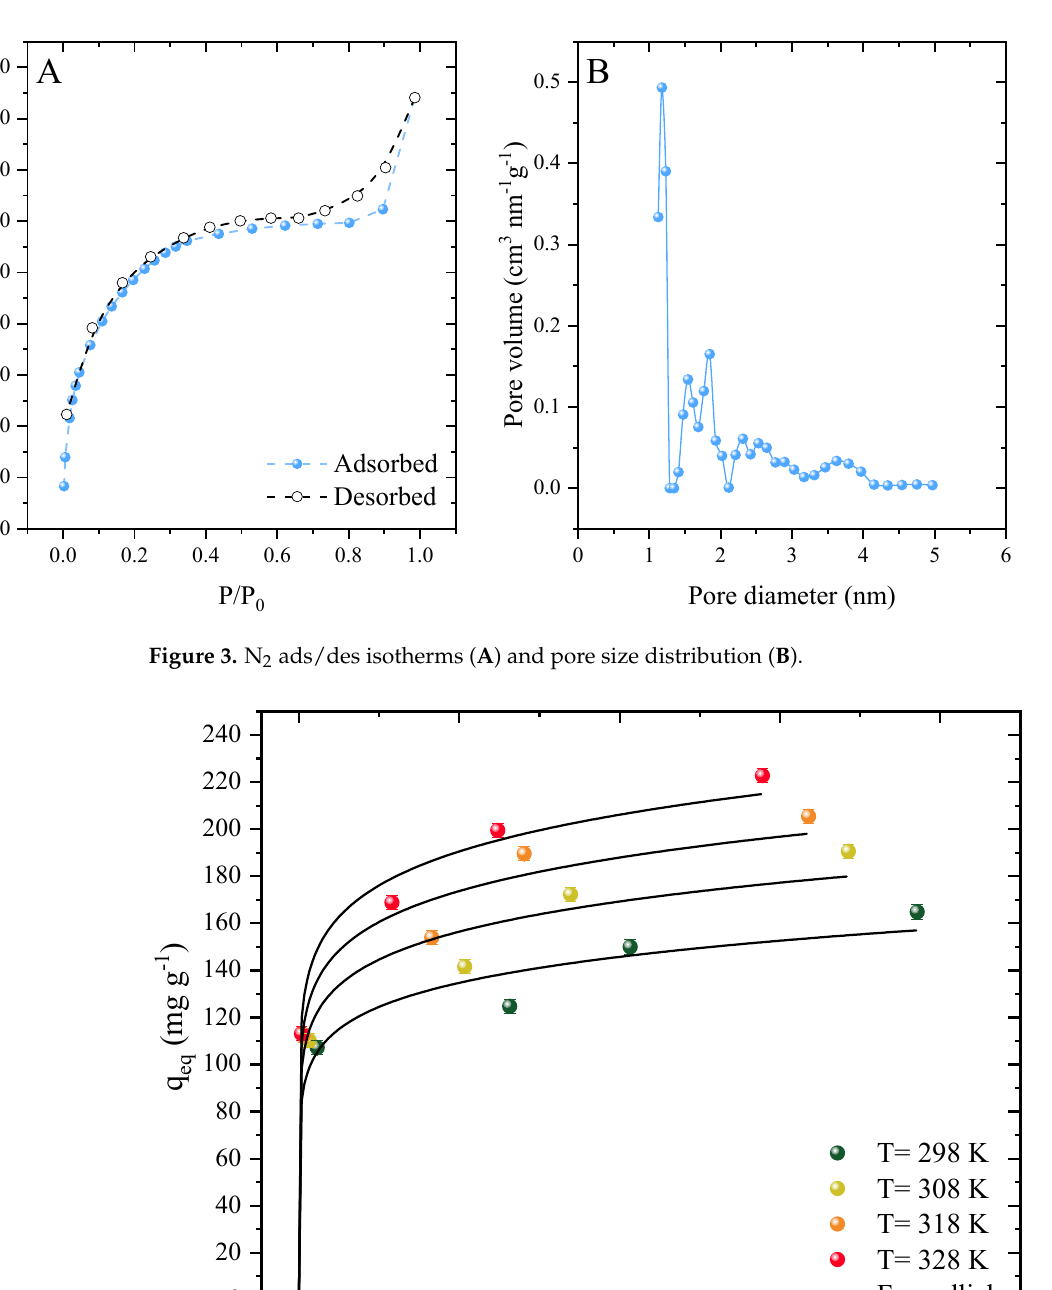
Figure 4. Adsorption isotherm data and Freundlich model prediction of Diuron in CPAC (D 0 = 0.5 g L −1 , pH natural = 7, V = 25 mL).